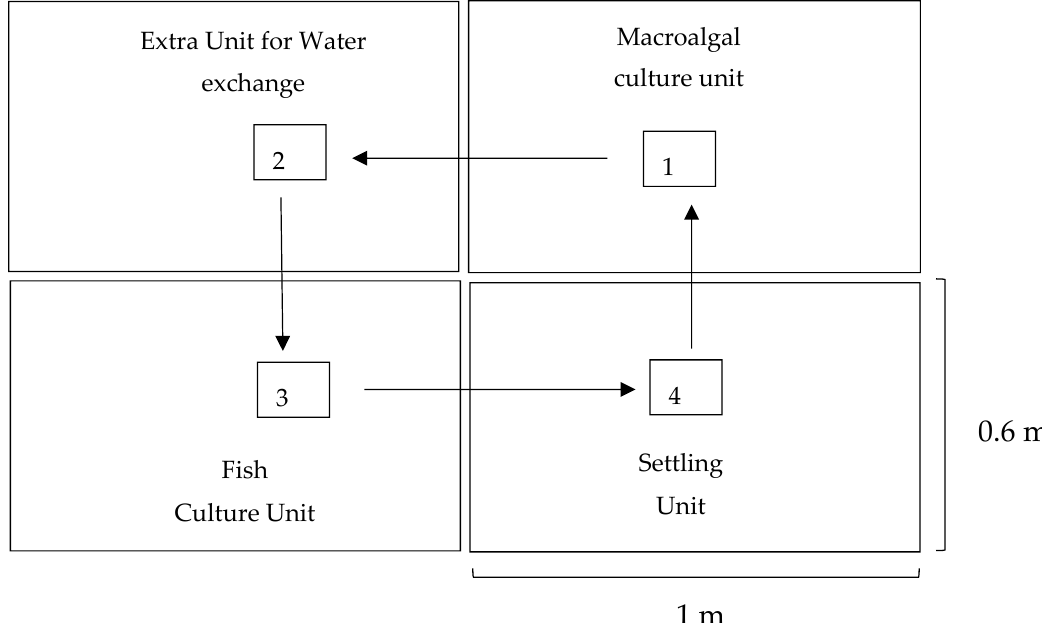
Figure 1. Diagram of flow patterns in a replicate of the fish macroalgae integrated recirculating aquaculture system.